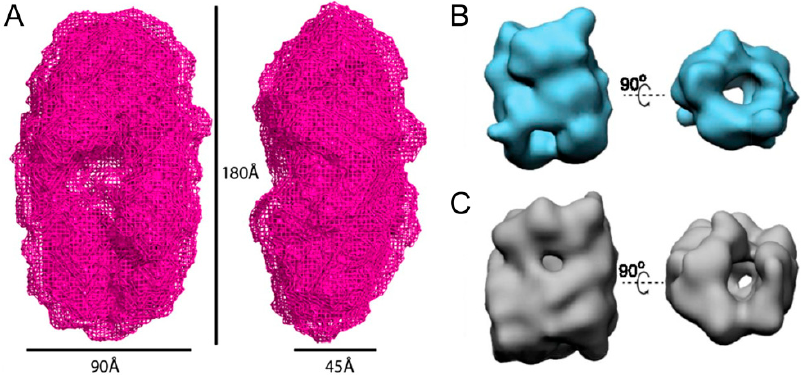
Figure 2. Current understanding of the structure of α -syn oligomers. ( A ) Structure of α -syn oligomers obtained by small angle X-ray scattering. The oligomer exhibits a 180 Å long and 90 Å wide circular shape with a cavity in the middle. ( B , C ) Structures of two subgroups of oligomers revealed by cryo-electron microscopy. Both subgroups have hollow cylindrical structures. ( A ) Adapted with permission from Reference [23], Proc. Natl. Acad. Sci. U.S.A. 2011, 108, 3246-3251. ( B , C ) Adapted with permission from Reference [24], Proc. Natl. Acad. Sci. U.S.A. 2015, 112, E1994-2003.